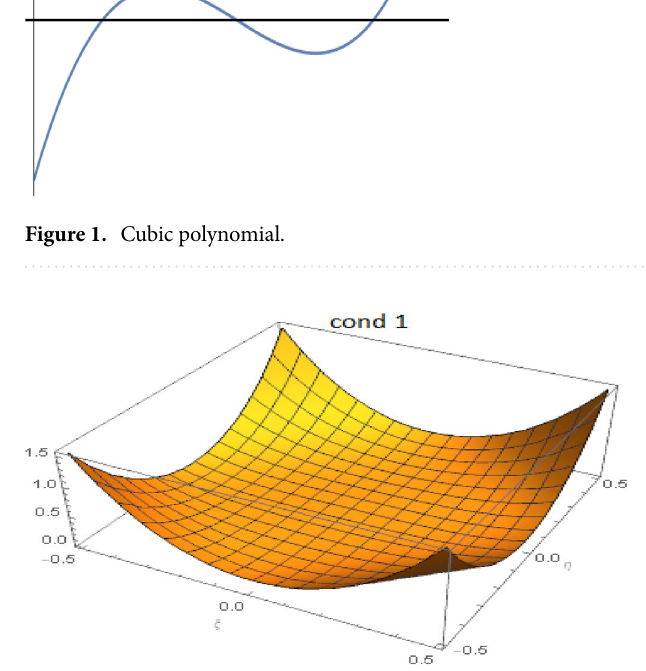
Figure 2. Satisfaction of the first condition for